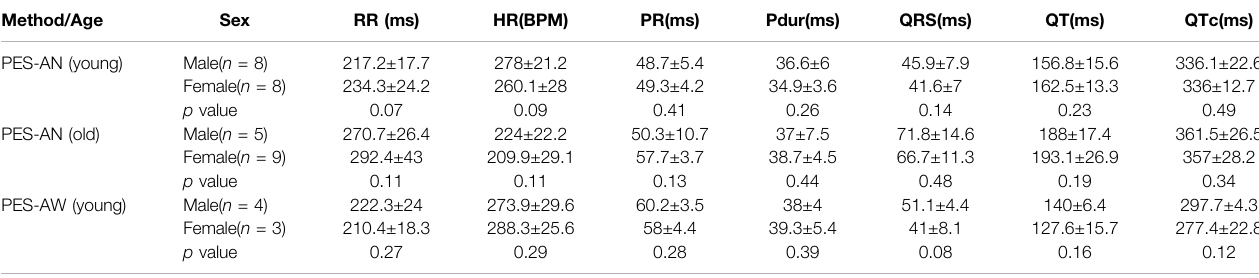
TABLE 10 | Sex-dependent effects in ECG parameters using a platform ECG system.